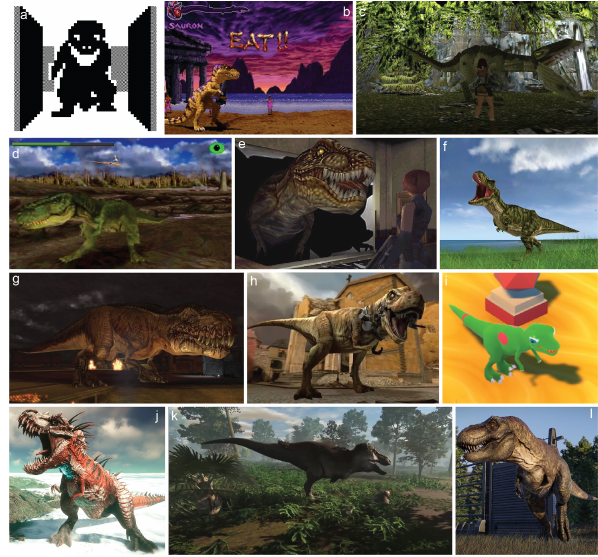
Figure 5. The representation of Tyrannosaurus rex in COTS video games through time. (a) 3D Monster Maze (1982, J. K. Greye Soft- ware). PC. (b) Primal Rage (1994, Midway Games West Inc) Super Nintendo Entertainment System. (c) Tomb Raider (1996, Core De- sign) PlayStation. (d) The Lost World: Jurassic Park (1997, Dream- Works Interactive) PlayStation. (e) Dino Crisis (1999, CAPCOM). PlayStation. (f) Jurassic Park: Operation Genesis (2003, Blue Tongue Entertainment) PC. (g) Turok (2008, Propaganda Games) PC. (h) Dino D-Day (2011, Digital Ranch) PC. (i) Parkasaurus (2020, Washbear Studio) PC. (j) Second Extinction (2020, Systemic Reaction) PC. (k) Saurian (2017, Urvogel Games, LLC). PC. (l) Jurassic World: Evolution (2018, Frontier Developments)